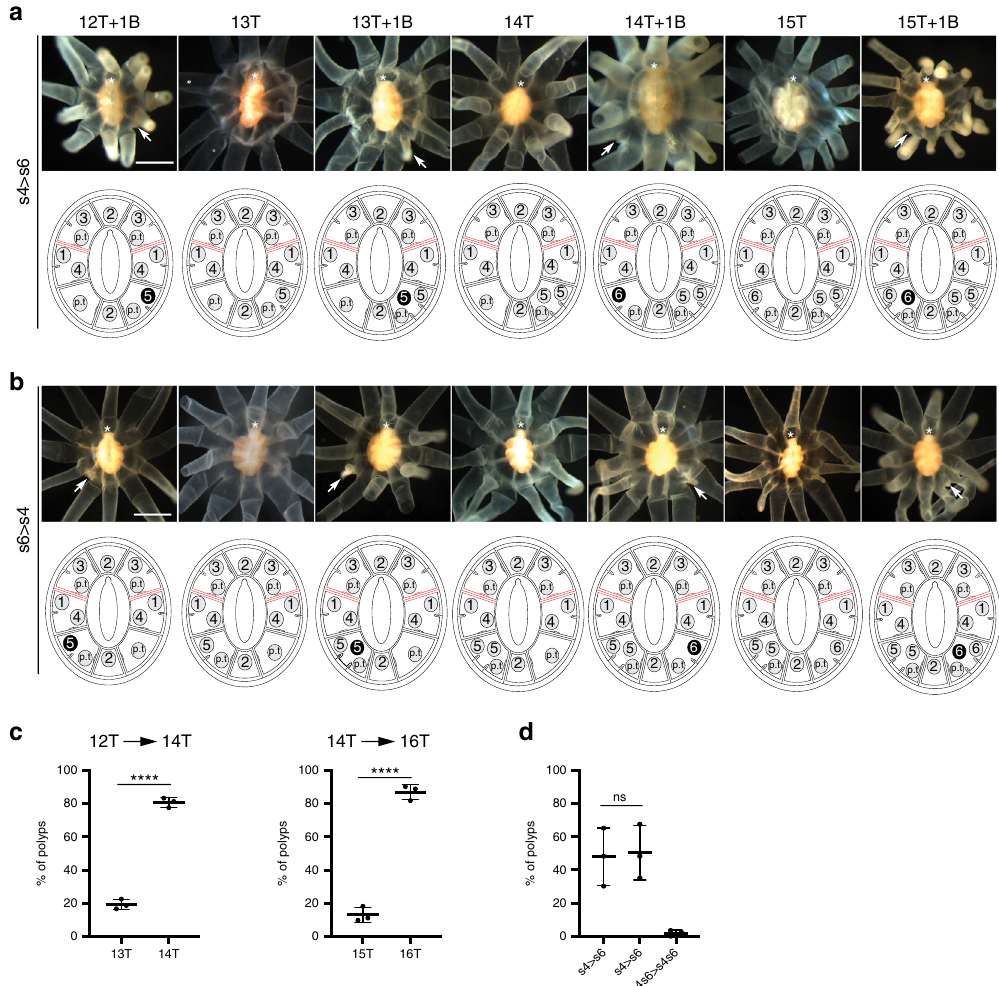
Fig. 3 Phase III of tentacle addition. a , b Oral views of fed polyps progressing from 12 to 16 tentacles. a Cis -budding events taking place in segment 4 then segment 6 (s4 > s6). Polyps with 12-tentacles with one bud (12 T + 1B, n = 10), 13-tentacles (13 T, n = 16), 13-tentacles with one bud (13 T + 1B, n = 30), 14-tentacles (14 T, n = 43), 14-tentacles with one bud (14 T + 1B, n = 3), 15-tentacles (15 T, n = 6), 15-tentacles with one bud (15 T + 1B, n = 20). b Alternative pattern of cis -budding events (s6 > s4, number of polyps are n = 4 for 12 T + 1B, n = 4 for 13 T, n = 25 for 13 T + 1B, n = 46 for 14 T, n = 4 for 14 T + 1B, n = 5 for 15 T, and n = 15 for 15 T + 1B). White arrows show the sites of budding events. All data are from three independent experiments. Scale bars are 500 μ m in all micrographs. Diagram showing tentacle arrangement is provided under each image. Tentacles and buds are depicted as gray and black discs, respectively. The numbers inside the discs indicate the sequence of budding. c Quanti fi cation of tentacle number including buds in growing polyps. Tentacle progression is indicated on the top of each graph ( n = 98, 137, and 85 polyps in three independently growing groups). d Quanti fi cation of budding sequence in growing polyps. S4s6 > s4s6 means two trans -budding events in s4 and s6 segments ( n = 56, 86, and 40 polyps in three independently growing groups). Data are mean ± SD for error bars (unpaired Student ’ s two-tailed t -test, **** p < 0.0001, ns nonsigni fi cant, p = 0.8699). Source data are provided as a Source data fi